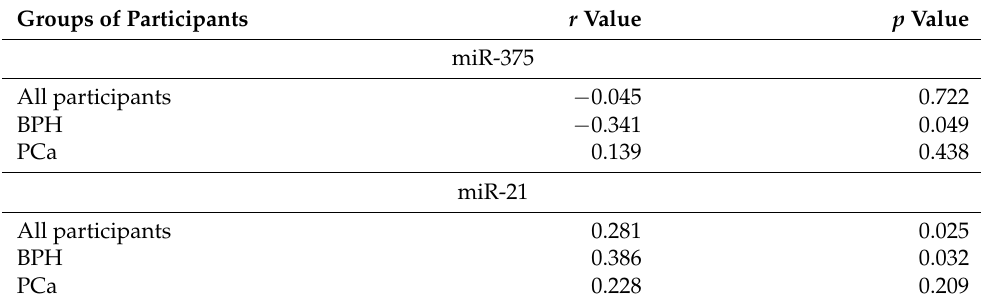
Figure 2. Differences in the expression levels of exosomal and whole-plasma microRNAs between PCa and BPH patients. Quantitative real-time polymerase chain reaction was executed to analyze the relative expression of miR-375 and miR-21 in exosomes ( a , b , respectively) and in plasma ( c , d , respectively). Reactions were normalized against the spike-in and endogenous controls (dCt, y -axis). Data are shown as interquartile ranges with means ± SD. A Student’s t -test was used to determine the statistical significance. PC—prostate cancer; BPH—benign prostatic hyperplasia; dCt—delta cycle threshold. Table 2. Correlation of microRNA expression levels between whole plasma and plasma-derived exosomes.